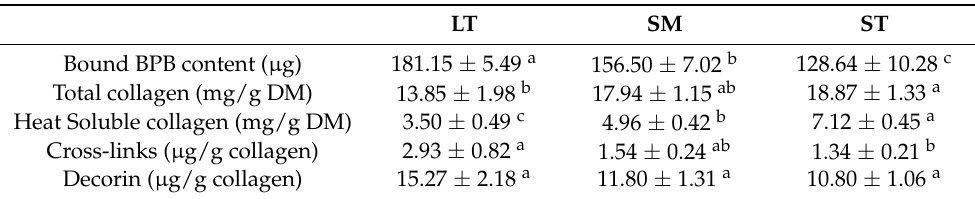
Table 3. Protein denaturation characterization (means ± SE, n = 11) of porcine longissimus thoracis , semimembranosus and semitendinosus